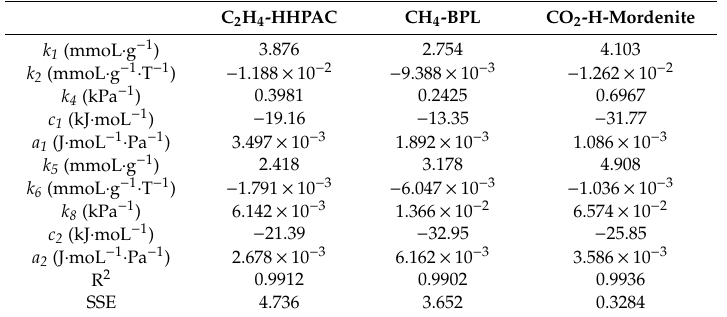
Table 10. The modified TDSL (M-TDSL) model parameters and errors for di ff erent